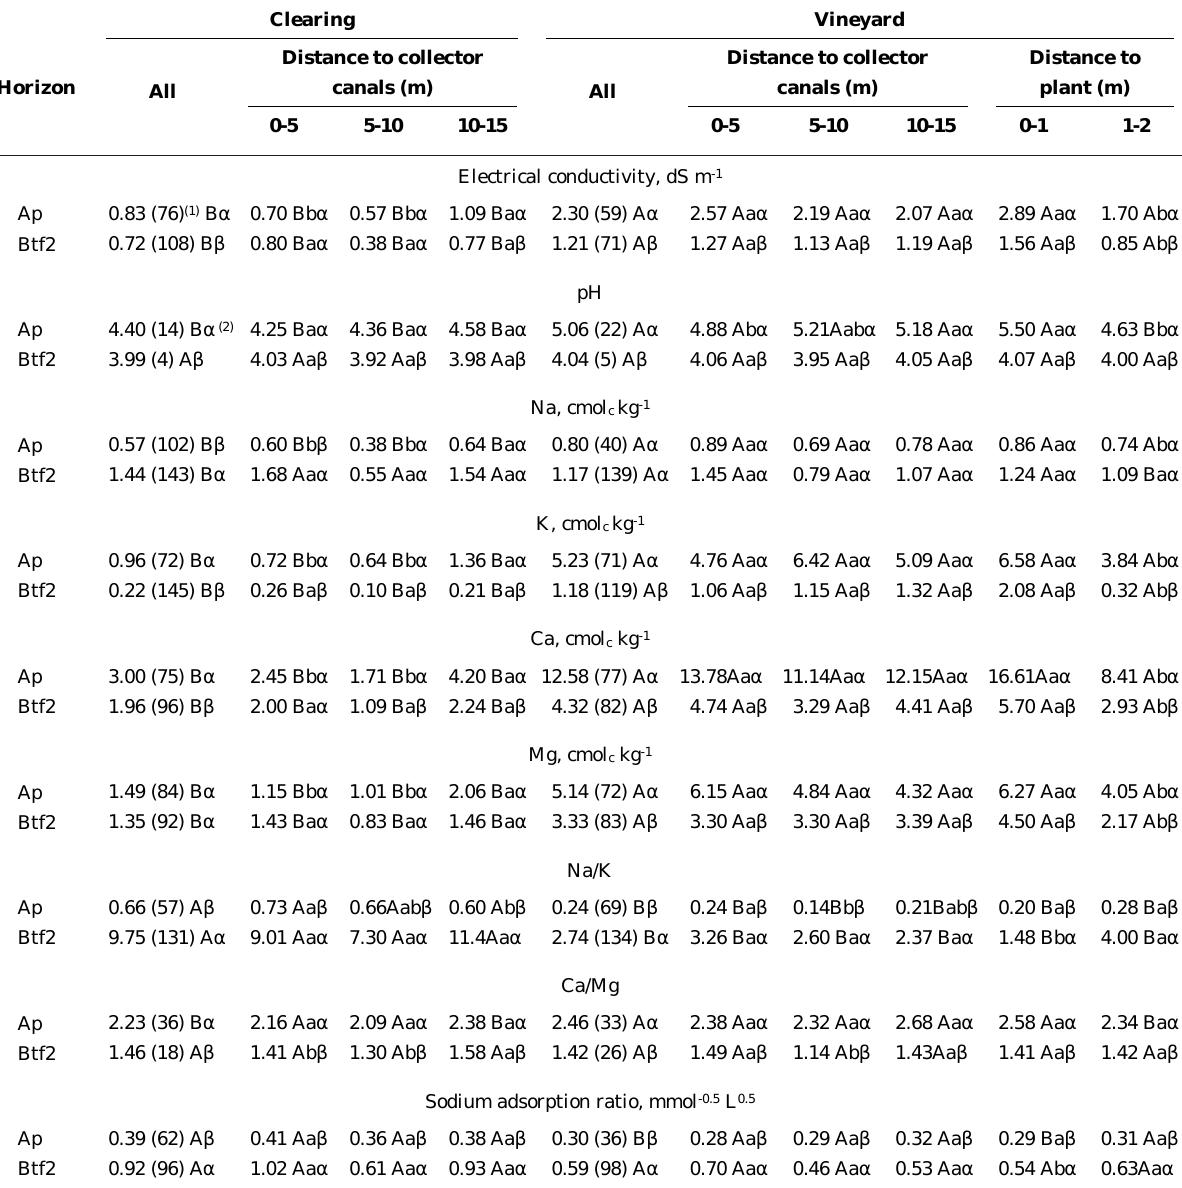
Table 7. Average composition of saturated paste extracts, according to sub-area as well as distance to collector canals and plants Clearing Vineyard Distance to collector canals (m)